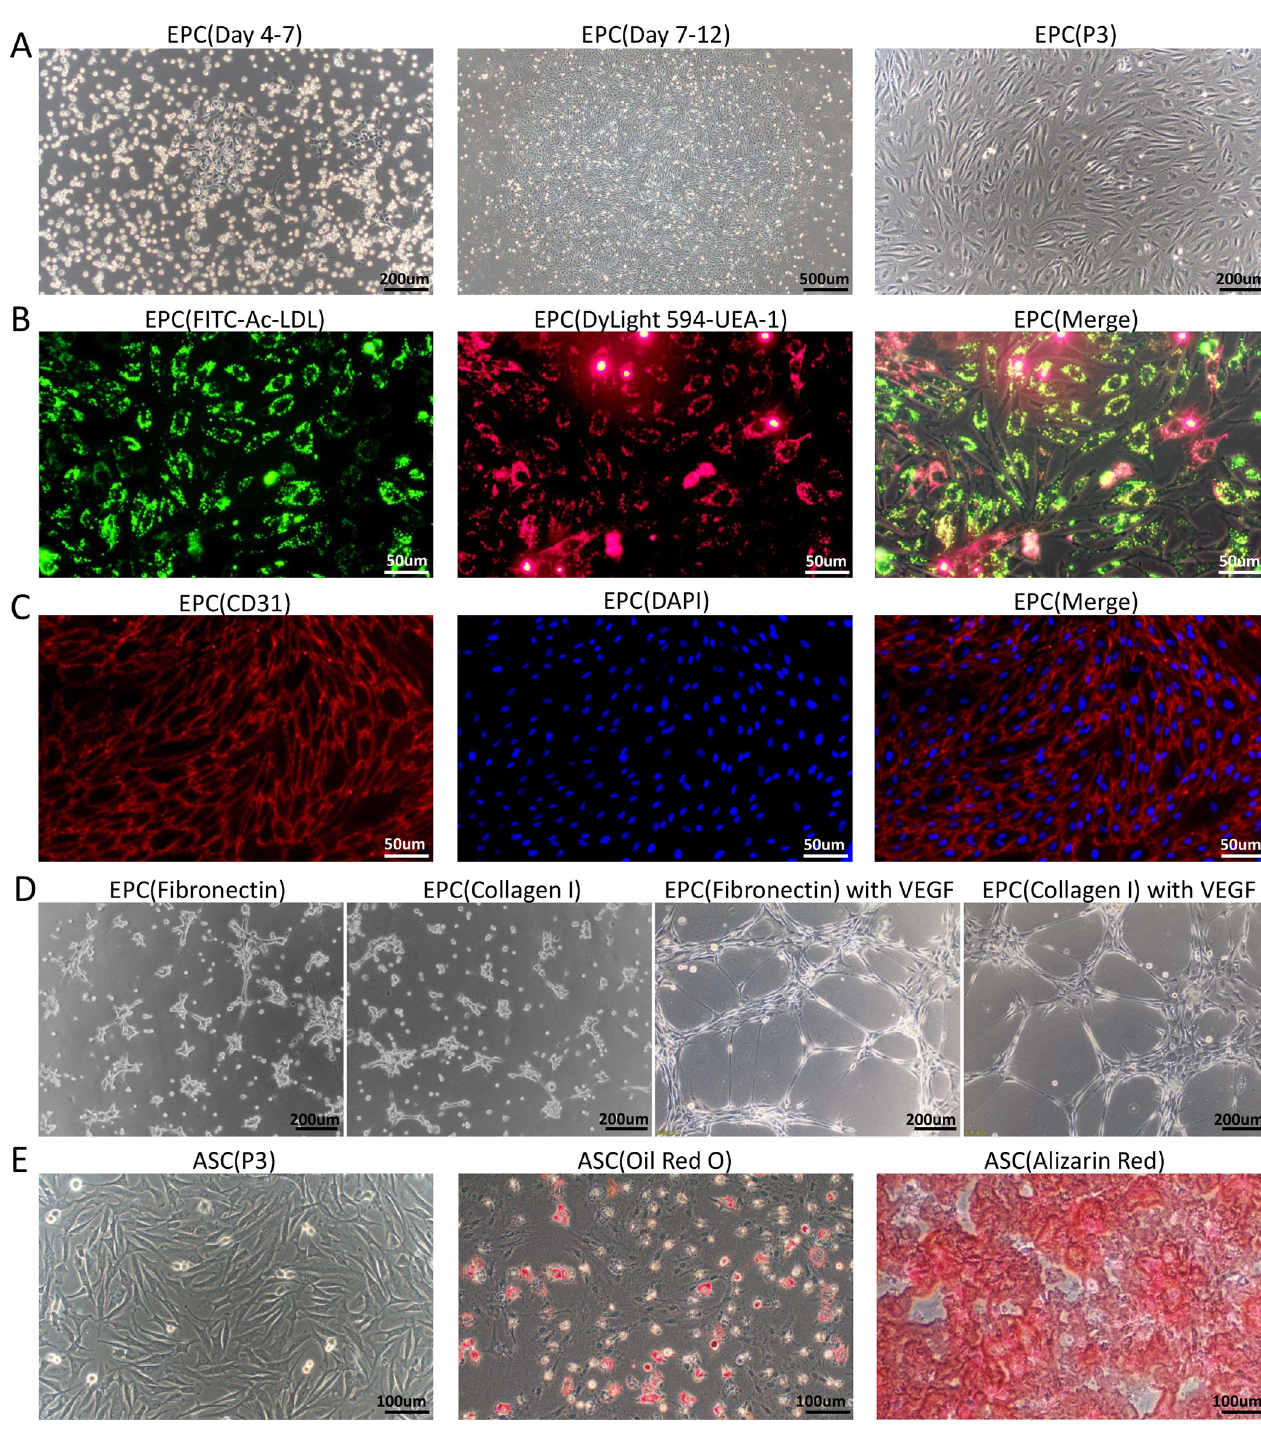
Fig 1. Isolation and characterization of rabbit EPCs and ASCs. (A)Rabbit peripheral blood mononuclear cells were seeded on plates pretreated with fibronectin and supplemented with EGM-2 complete medium. At 4 to 7 days, adherent cells with typical cobblestone-like morphology appeared. At 9–12 days, the EPCs expanded into colonies. Third-passage EPCs cultured in complete EGM-2 medium exhibited spindle-like morphology under inverted phase-contrast microscopy. (B) The functional characteristics of EPCs were assessed by testing their ability to take up FITC-Ac-LDL and bind to DyLight 594-UEA-1. The results were visualized with fluorescence microscopy. (C) Immunofluorescent staining revealed the expression of endothelial cell marker CD31 in EPCs. Cell nuclei are stained with DAPI. (D) Representative mages of the tube formations of EPCs isolated by fibronectin or collagen I coating methods, the EPCs were resuspended with EGM2 basal medium containing 50ng/ml VEGF or not, respectively. (F) Third-passage ASCs cultured in complete EGM-2 medium